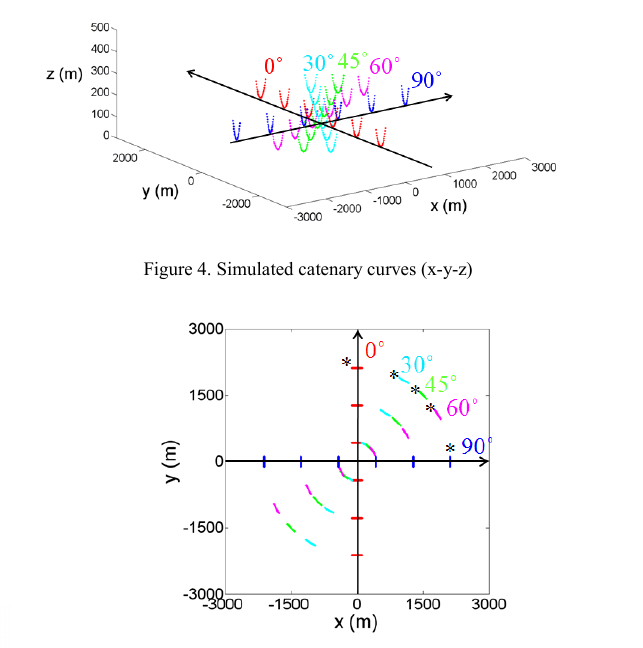
Figure 5. Simulated catenary curves (x-y)